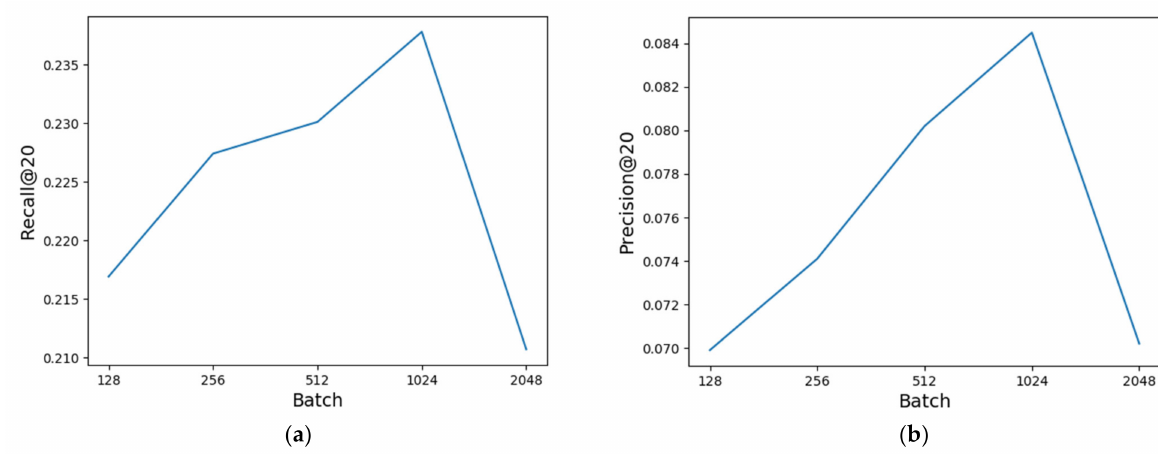
Figure 6. Effects of hyper-parameter batch in terms of Recall@20 and Precision@20 in the dataset of MovieLens-1M: ( a ) effects of hyper-parameter K in terms of Recall@20; ( b ) effects of hyper-parameter batch in terms of Precision